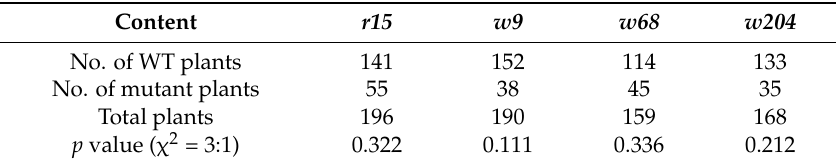
Figure 4. Phenotypes of F 1 and F 2 populations in different mutant lines. F 1 generation of: r15 ( A ); w9 ( B ); w68 ( C ); and w204 ( D ). Ten individuals of each line were collected for observation. Partly F 2 individuals of: r15 ( E ); and w68 ( F ). Table 2. Segregations of F 2 populations crossed by the WT.